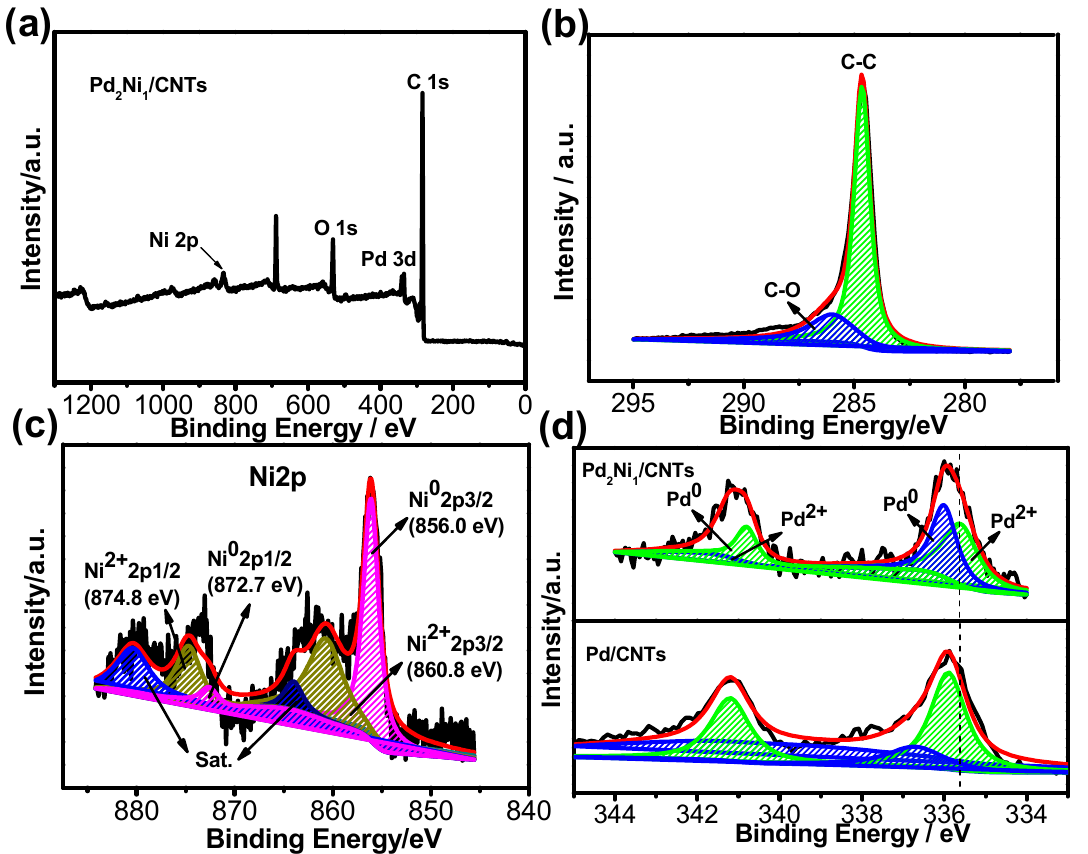
Figure 3. ( a ) XPS survey spectra, ( b ) C (1s) spectrum, ( c ) Ni (2p) spectrum of Pd 2 Ni 1 /CNTs, ( d ) Pd (3d) spectrum of Pd 2 Ni 1 /CNTs and Pd/CNTs.